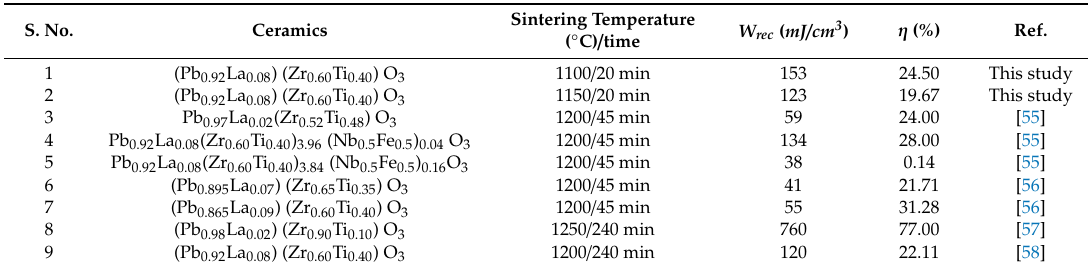
Table 4. Comparison of energy storage properties of microwave-sintered PLZT 8 / 60 / 40 ceramics and other lead-based ferroelectric PLZT